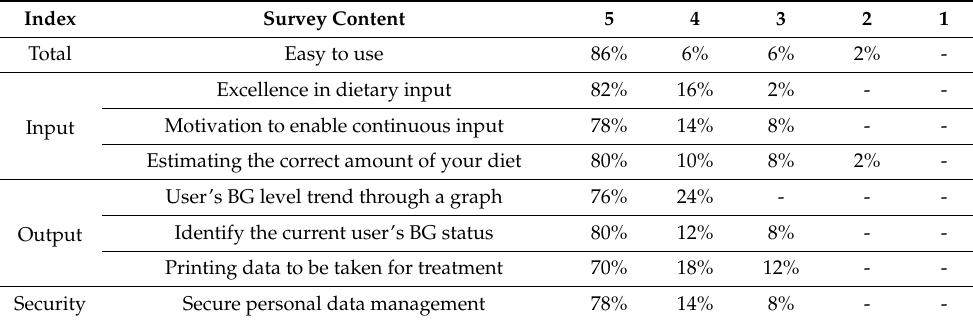
Table 7. Survey results for characteristics of the proposed self-management IoT platform.